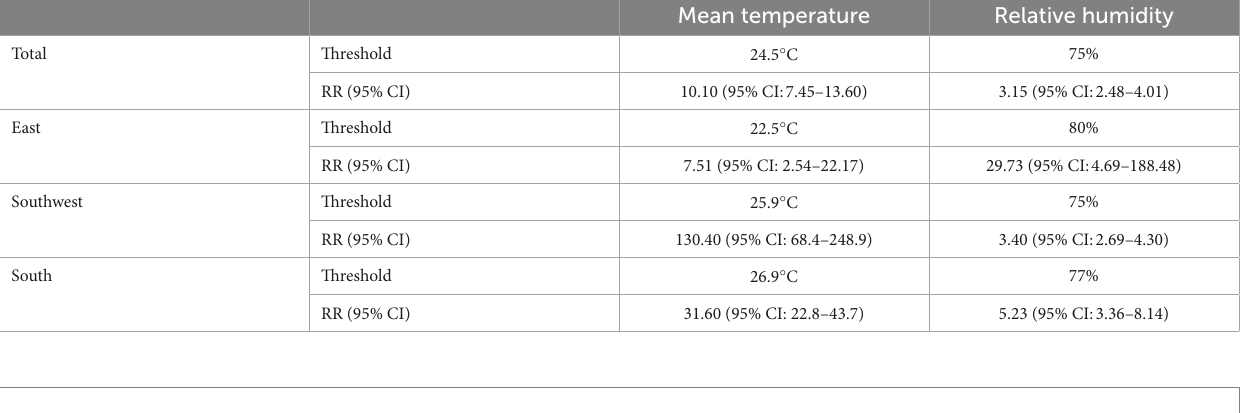
TABLE 1 Threshold values of weekly mean temperature and relative humidity and the corresponding cumulative relative risk (RR) at total and regional levels.